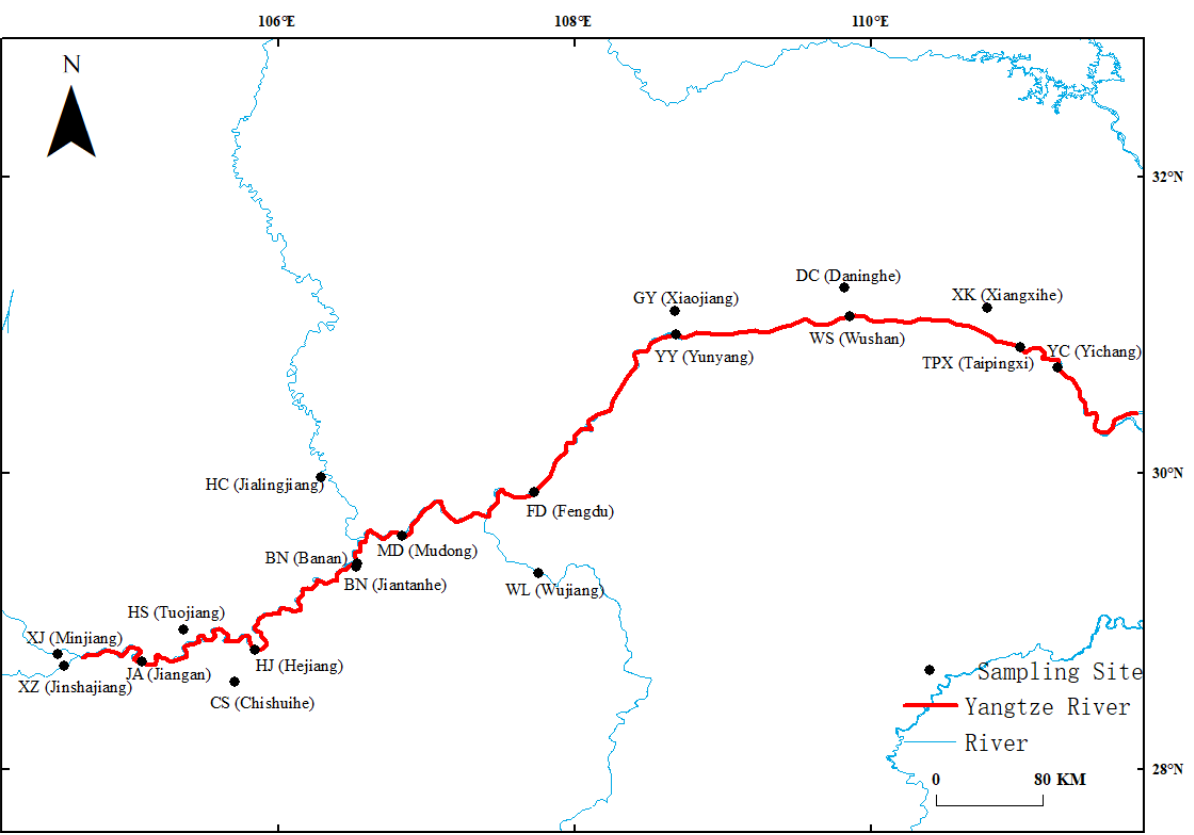
Figure 1. Sampling locations in the upper part of the Yangtze River.